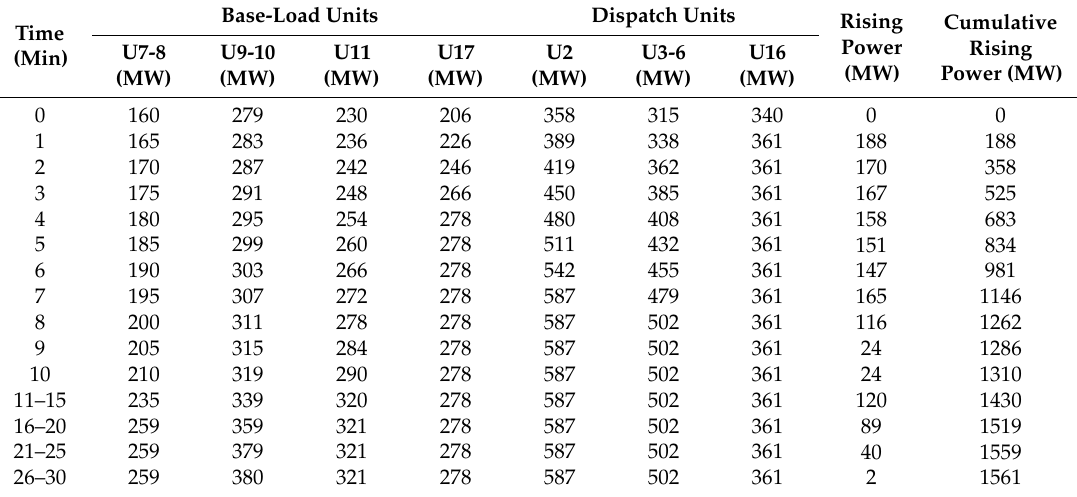
Table 3. The unit commitment (UC) problem solved using the HA to increase power output by 1560 MW within 30